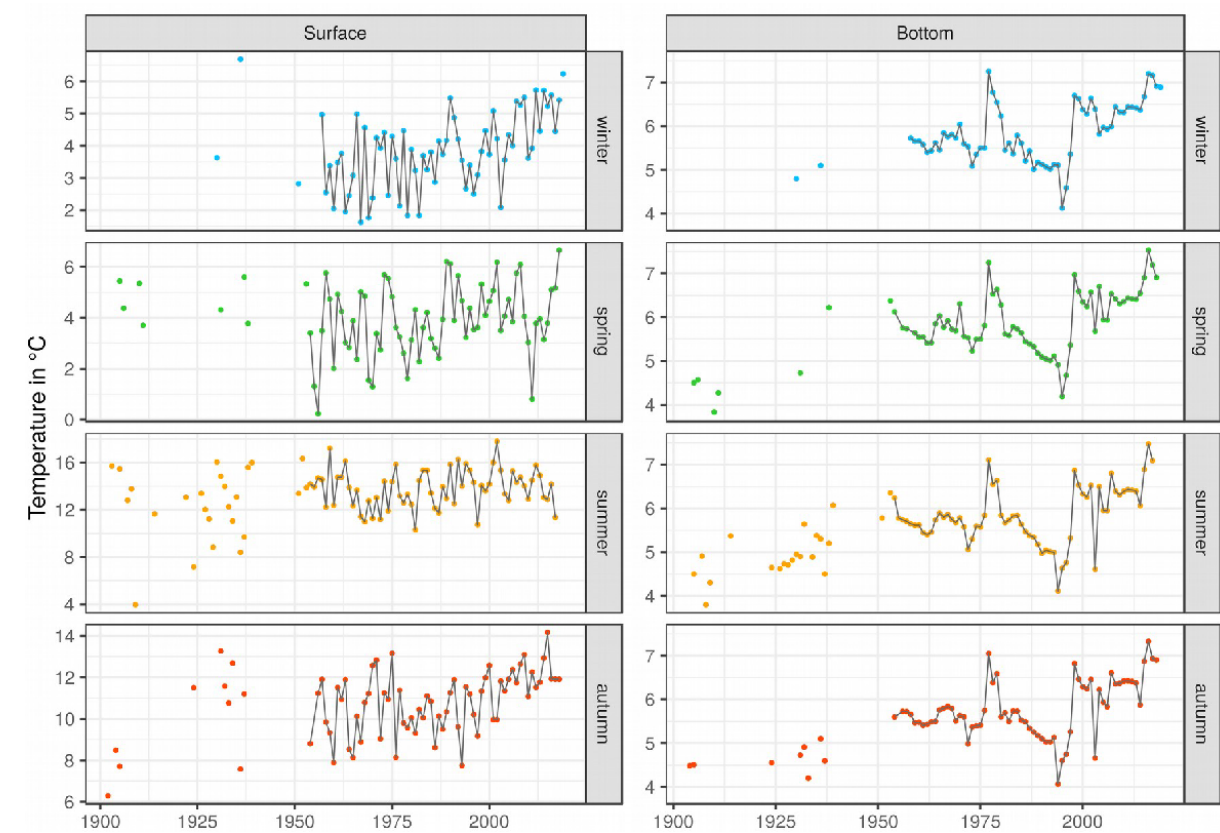
Figure 19. Seasonal mean sea surface and bottom temperature values during 1877–2018 at Gotland Deep (BY15). Blue, green, yellow, and orange show winter, spring, summer, and autumn, respectively. The grey lines show the period when every station has data for every year (1954–2018).